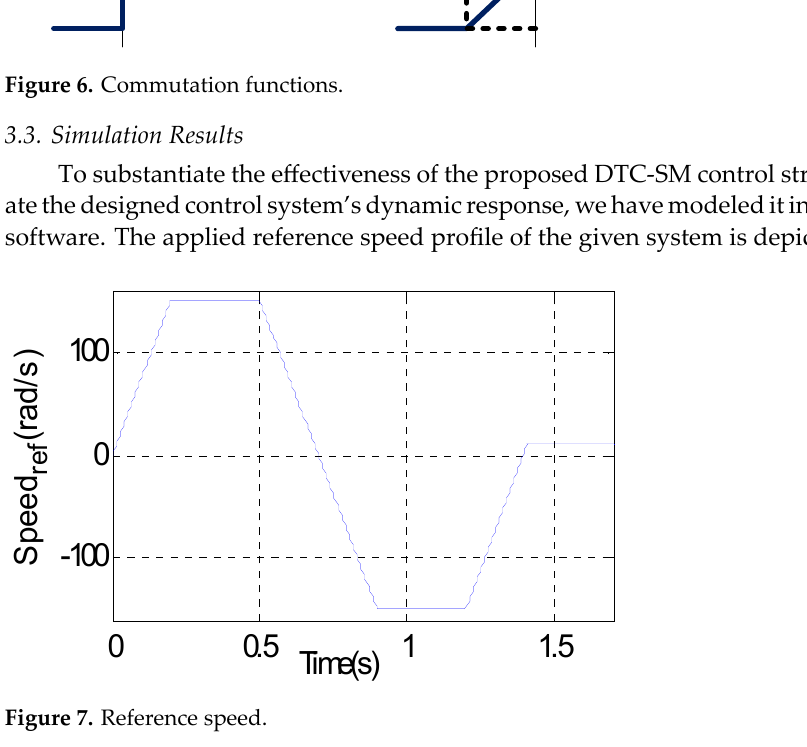
Figure 6. Commutation functions.